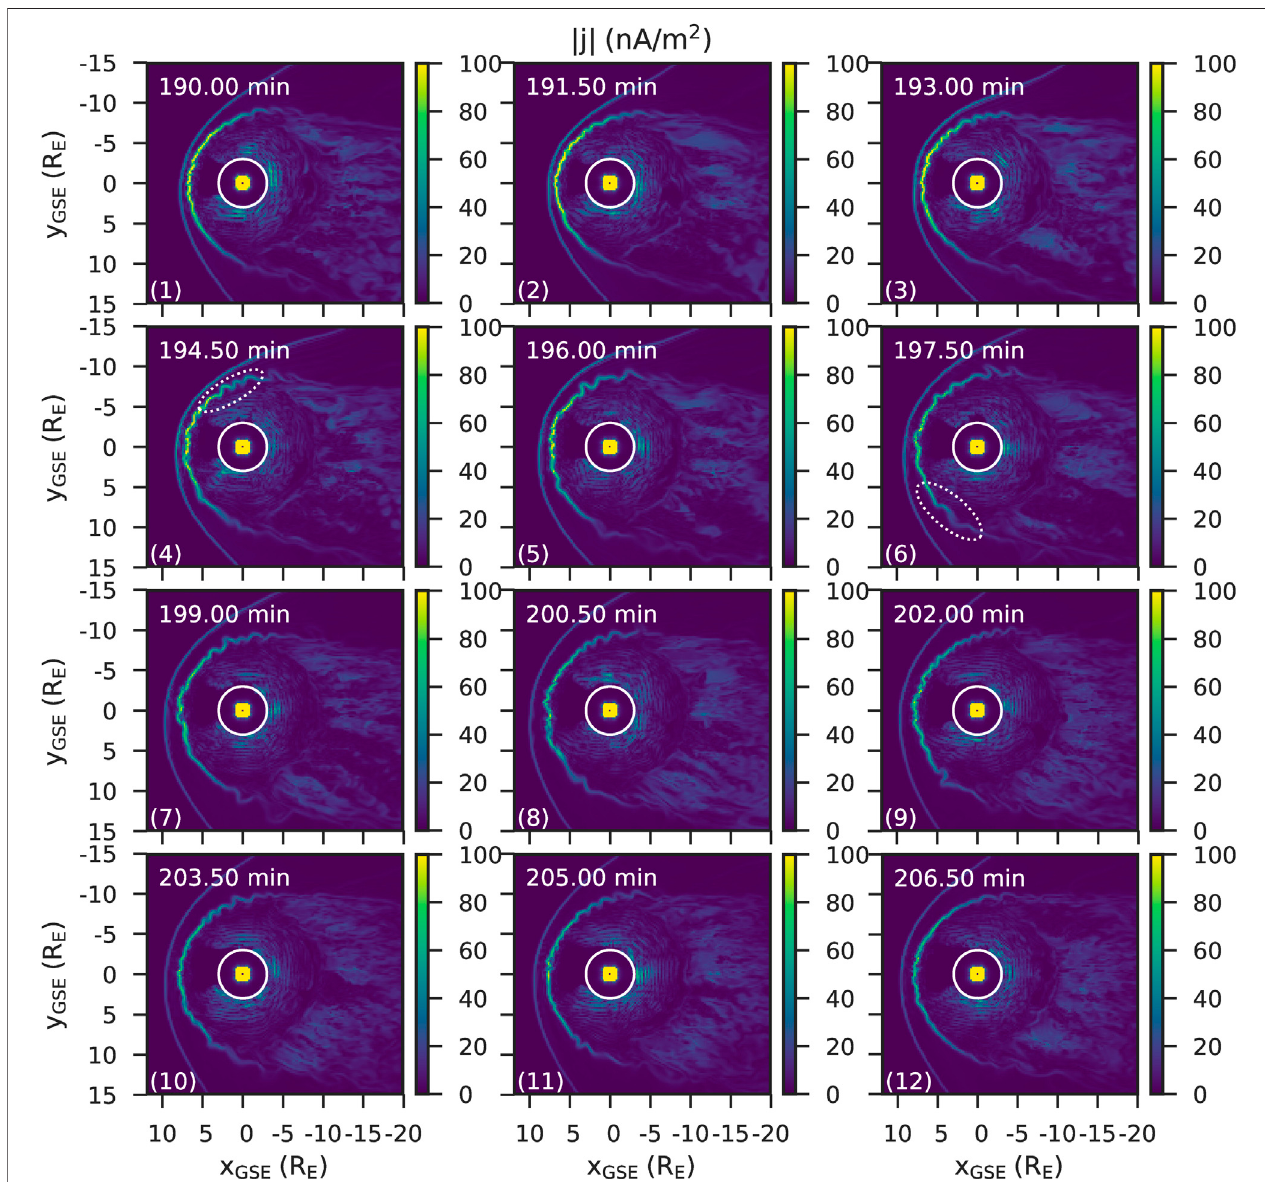
FIGURE 3 | The magnitude of the current density in the ecliptic plane every 1.5 min from t (cid:2) 190min to 206 . 5min. As with Figure 2 , the solar wind streams from the left. The compression of the magnetic fi eld through the bow shock is shown as the left most current density peak. The magnetopause current sheet follows shortly after. Rather than a simple conical shape, it has oscillatory and transient structures. In the magnetotail, the white circle is the inner boundary of the simulation, of radius 3 R E . The subsequent sharp decrease moving to the right is the